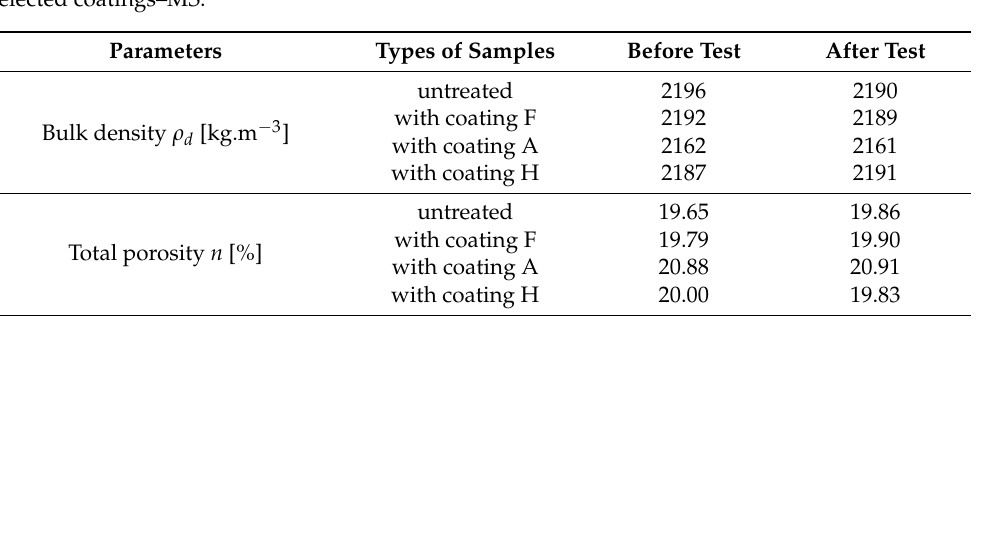
Table 5. Impact of the freeze–thaw cycling on the properties of untreated samples and samples with selected